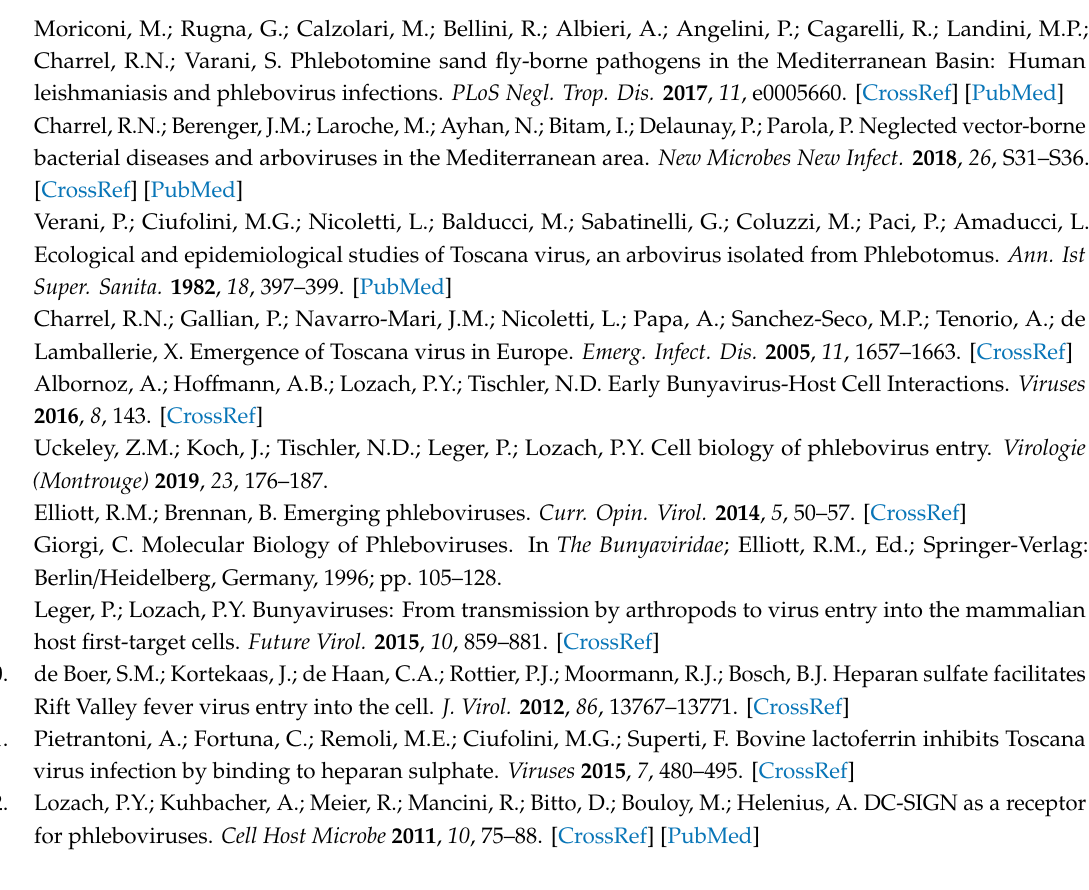
Figure S1: Sequences of the 3 (cid:48) and 5 (cid:48) ends of the TOSV genomic segments in the pUC57 and pCC1 plasmids, Figure S2: Alignment of the wt and mutated TOSV NSs nucleotide sequence in the S segment, and Figure S3: Sucrose-gradient purification of